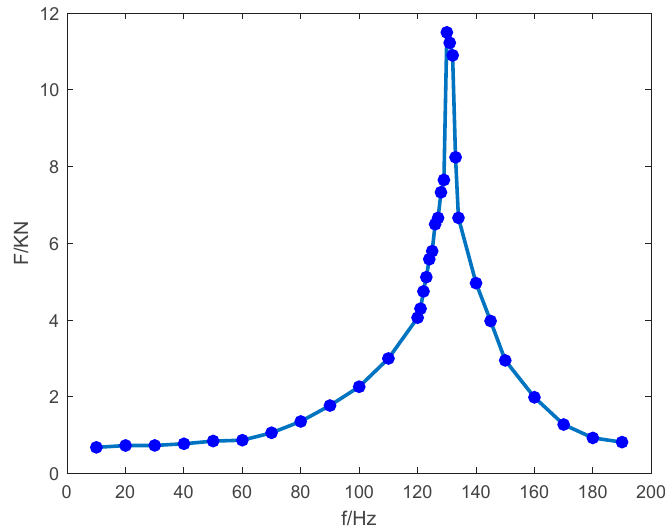
Figure 15. Thrust-frequency fitting curve.